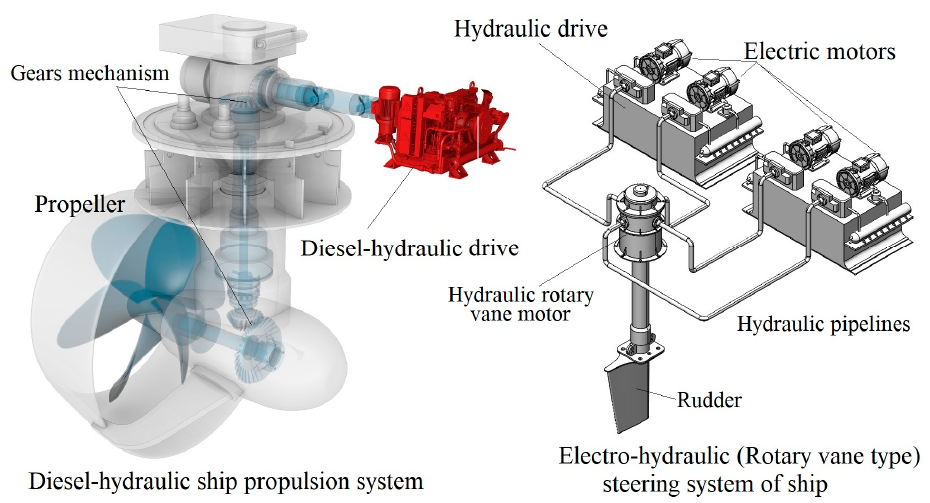
Figure 1. Applications of the use of the hydraulic drive in the ships.